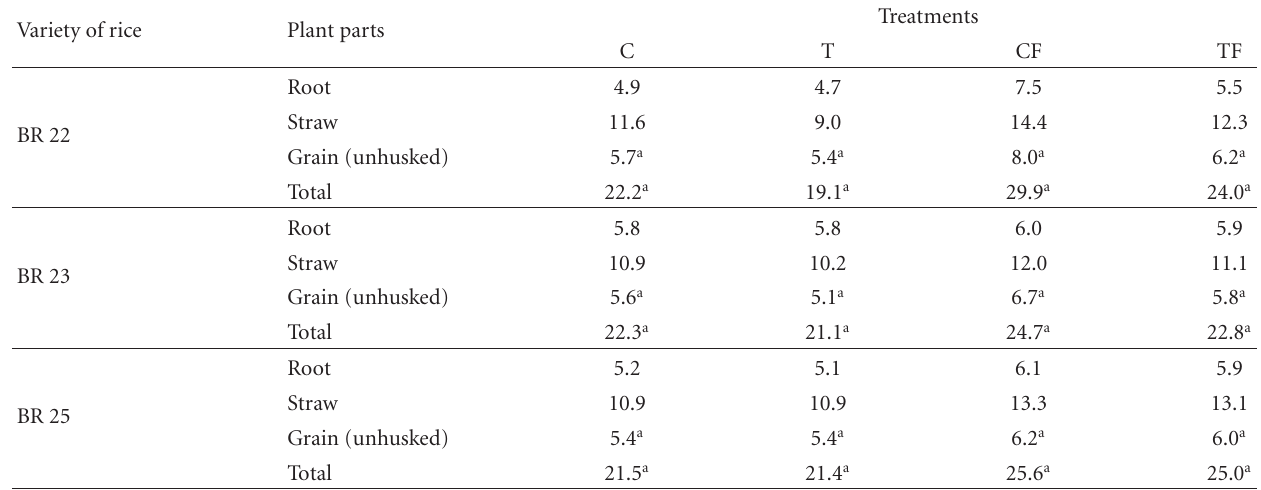
Table 4: Yield (g) of the aman rice plants.